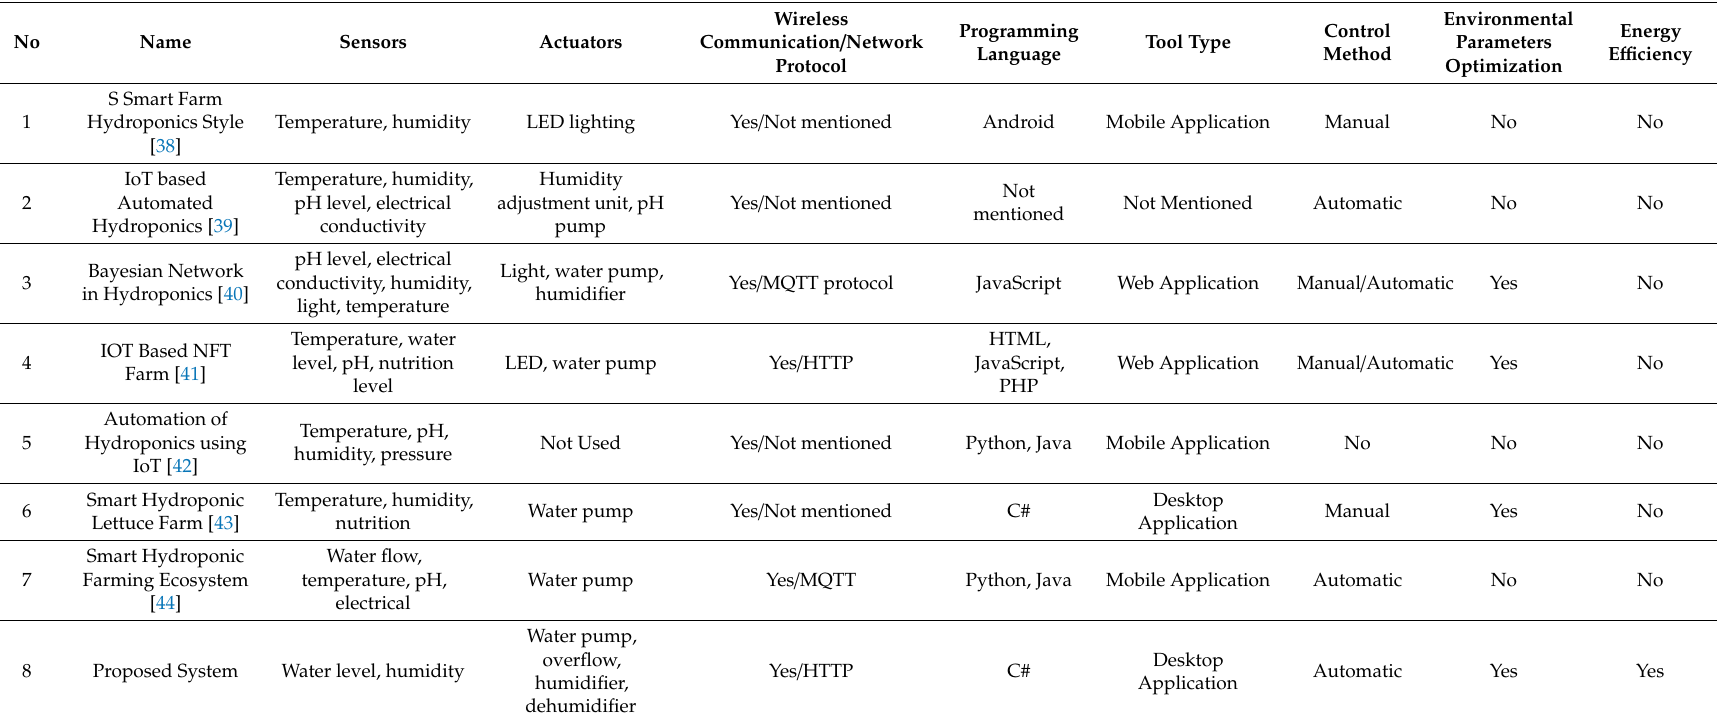
Table 7. Comparative analysis of the proposed system with existing